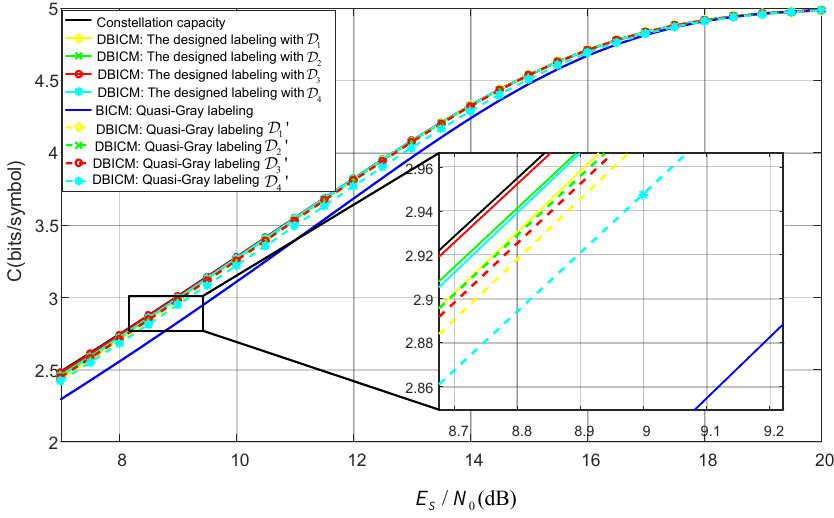
Figure 6. Channel capacity for our designed labeling and quasi-Gray